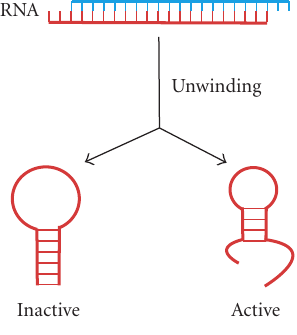
Figure 4: Influence of guide RNA structure on siRNA e ffi ciency [50]. siRNA guide strands with base-paired termini were found to be inactive, whereas guide RNAs with freely accessible ends (mainly 3 (cid:2) ends) were highly e ffi